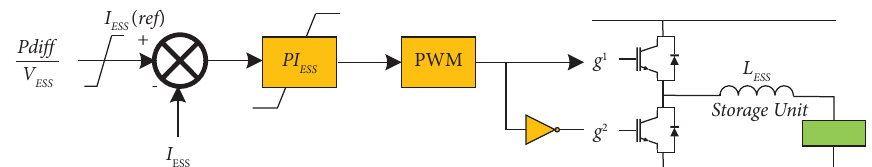
Figure 5: Te connection of the storage unit to the DCL via a DC\DC converter with the control system.